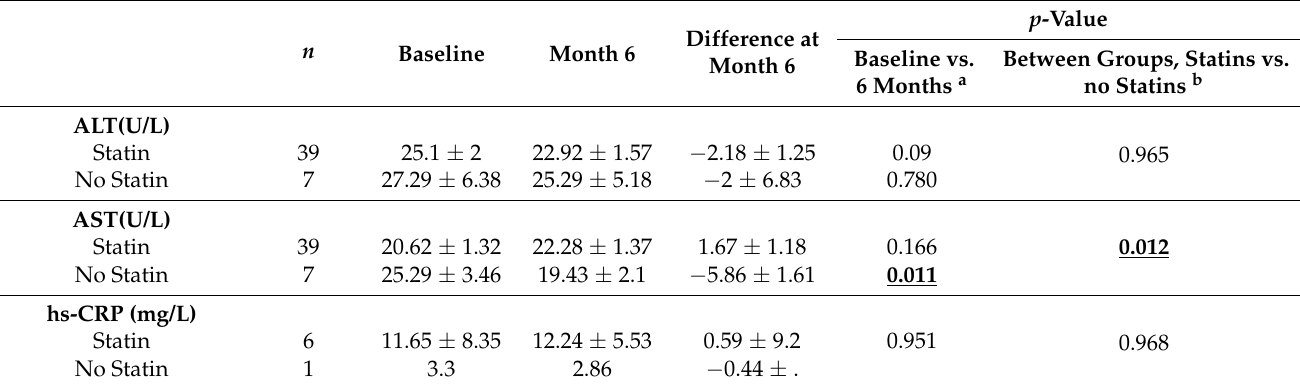
Table 5. Changes of ALT, AST, and hs-CRP levels from the baseline to 6 months in type 2 diabetes mellitus subjects treated with GLP-1RAs.